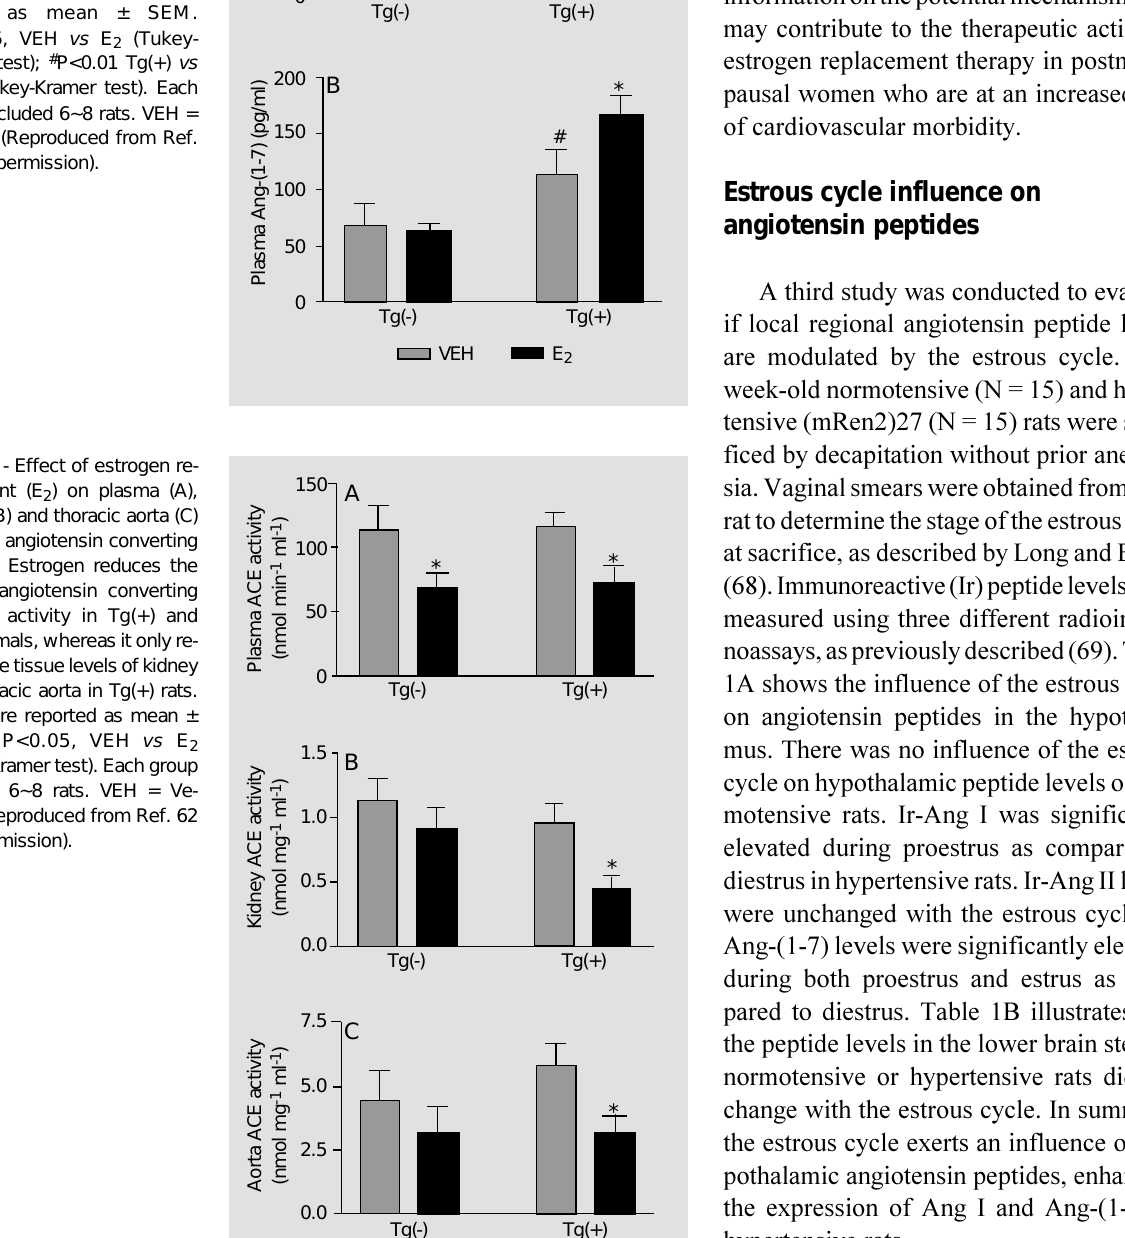
Figure 5 - A , Effects of estrogen replacement (E 2 ) on plasma lev- els of Ang II. Estrogen reduces the circulating levels of plasma Ang II in Tg(+) animals. B , Ef- fects of estrogen replacement (E 2 ) on plasma levels of Ang-(1- 7). Estrogen increases the circu- lating levels of plasma Ang-(1-7) in Tg(+) animals. Values are re- ported as mean ± SEM. *P<0.05, VEH vs E 2 (Tukey- Kramer test); # P<0.01 Tg(+) vs Tg(-) (Tukey-Kramer test). Each group included 6~8 rats. VEH = Vehicle. (Reproduced from Ref.